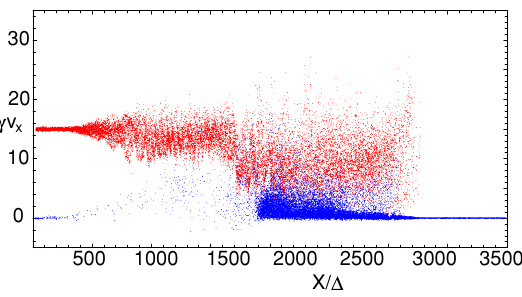
Figure 3. Phase-space distribution of the jet (red) and the ambient (blue) electrons at t = 3250 ω − 1 pe . About 18,600 electrons of both species are selected randomly. Adapted from Figure 2 in